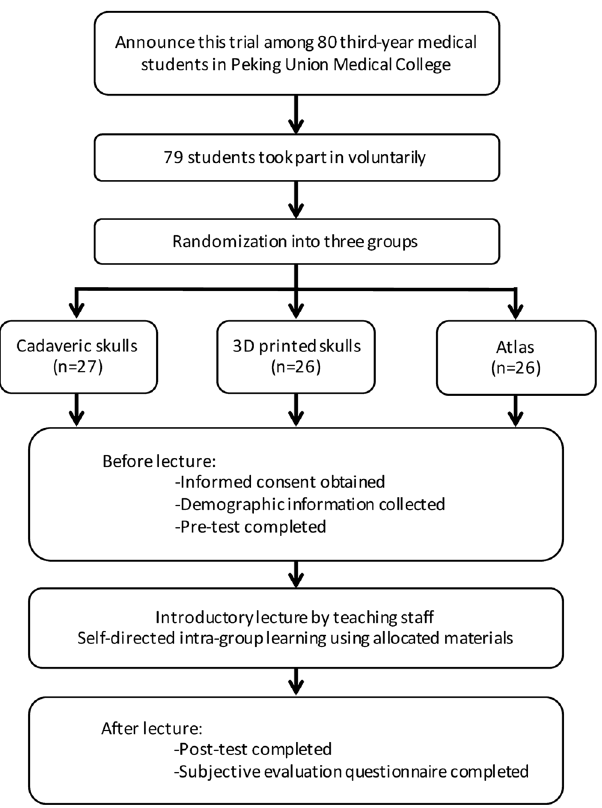
Figure 3. Flowchart of study